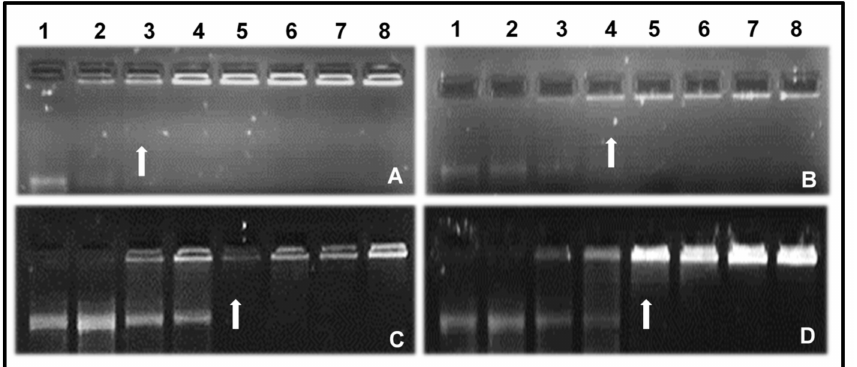
Figure 4. Band shift assay of the interaction between ( A ) G5D, ( B ) Au:G5D, ( C ) G5D:FA, ( D ) Au:G5D:FA, and mRNA. Incubation mixtures (20 µ L) in HBS contained varying amounts of the nanoparticle preparation and 0.05 µ g FLuc-mRNA corresponding to w / w ratios of 1:1, 2:1, 3:1, 4:1, 5:1, 6:1, 7:1, and 8:1 in lanes 2–8, respectively ( A – D ). Lane 1: naked mRNA control. Arrows indicate endpoint ratios.